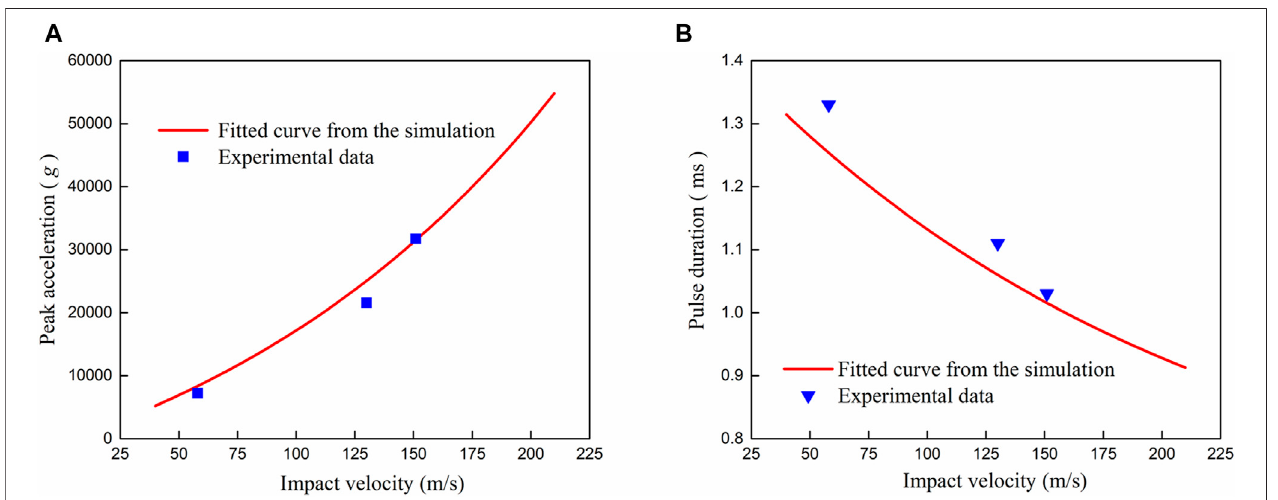
FIGURE 15 | (A) Comparisons between the numerical fi tting curves and (B) the experimental